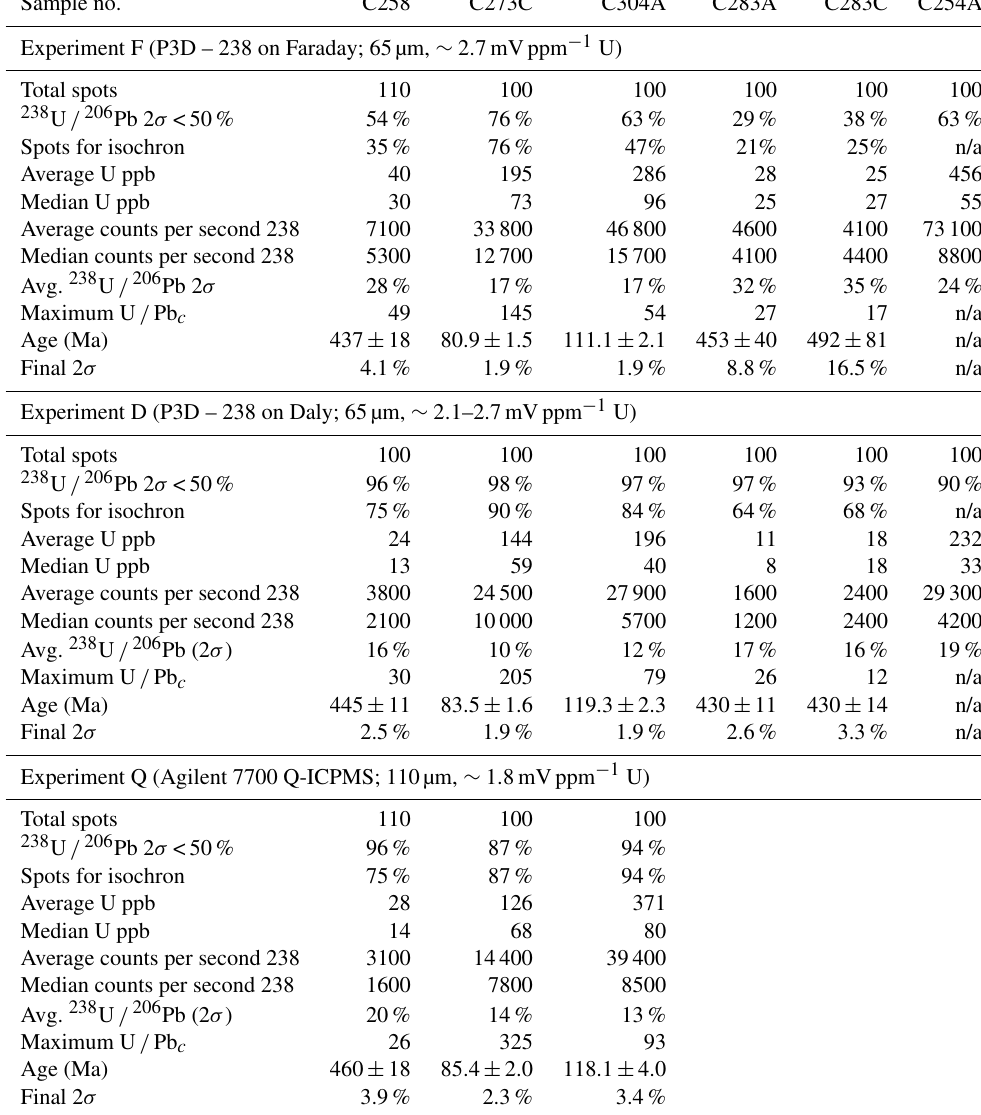
Table 2. Results from three experiments; n/a means not applicable. Sample no. C258 C273C